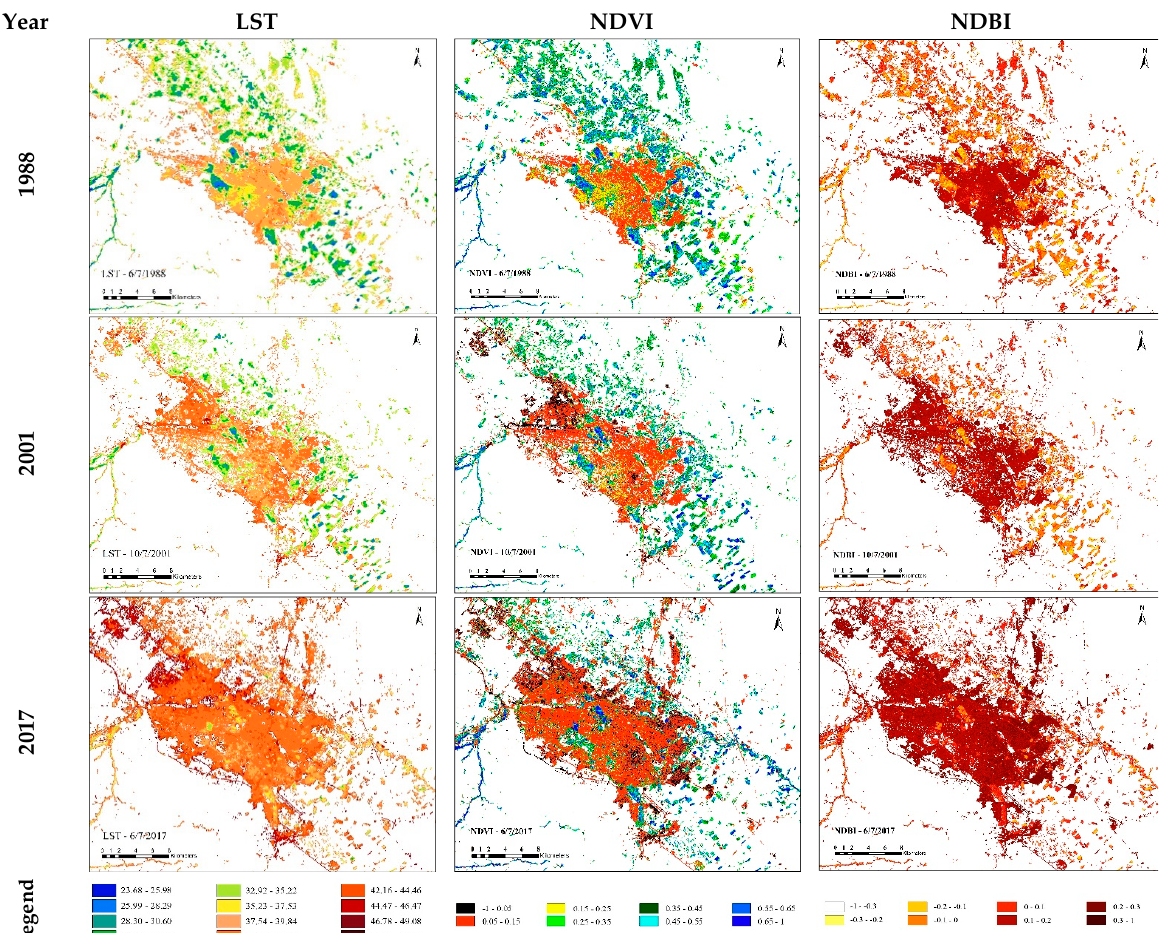
Figure 5. Land surface temperature (LST), normalized deference vegetation index (NDVI) and normalized difference built-up index (NDBI) in 1988, 2001 and 2017.